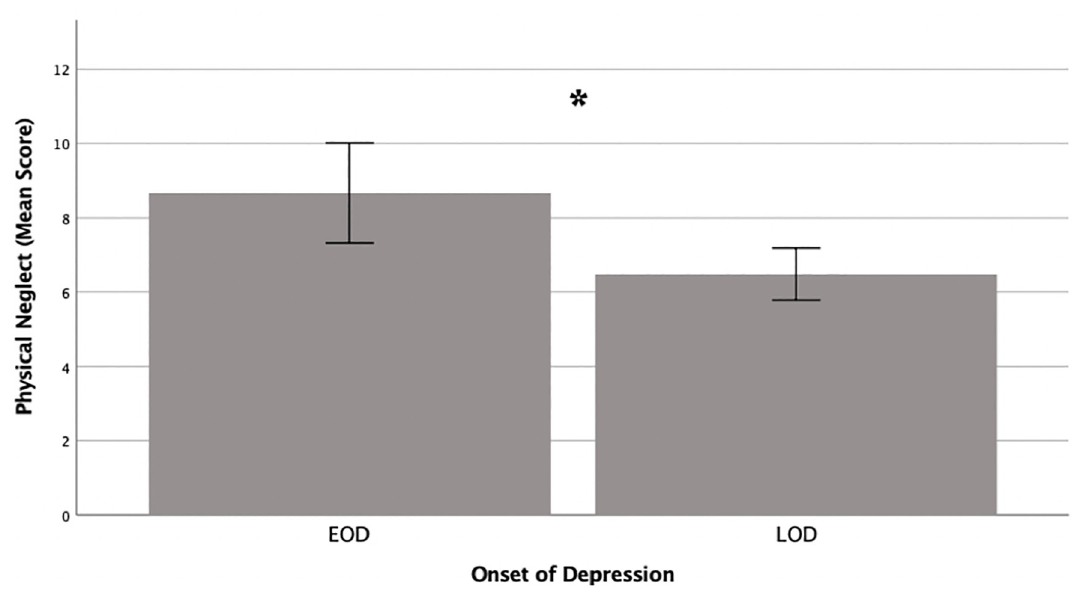
Fig 1. Difference of physical neglect between patients with Early Onset Depression (EOD) and Late Onset Depression (LOD).